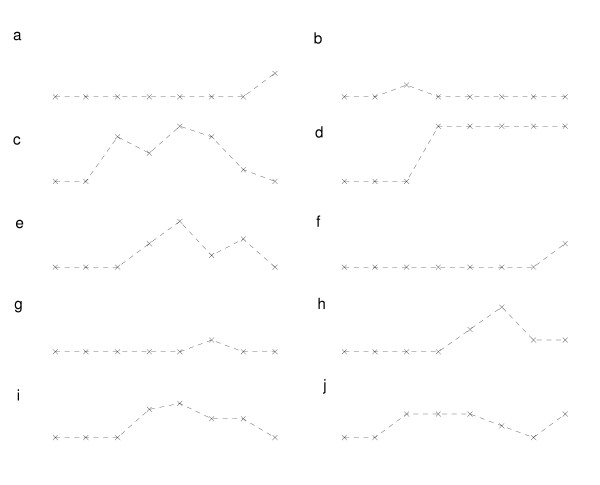
Proportion of pigs seropositive by age for ten seropositive herds that had completely seronegative young stock and purchased replacement gilts. x axis = Age of pigs or parity of sow (from left to right: 8 weeks, 14 weeks, gilts, parity 1, parity 2, parity 3, parity 4, parity 5+), y axis = Proportion of pigs seropositive.